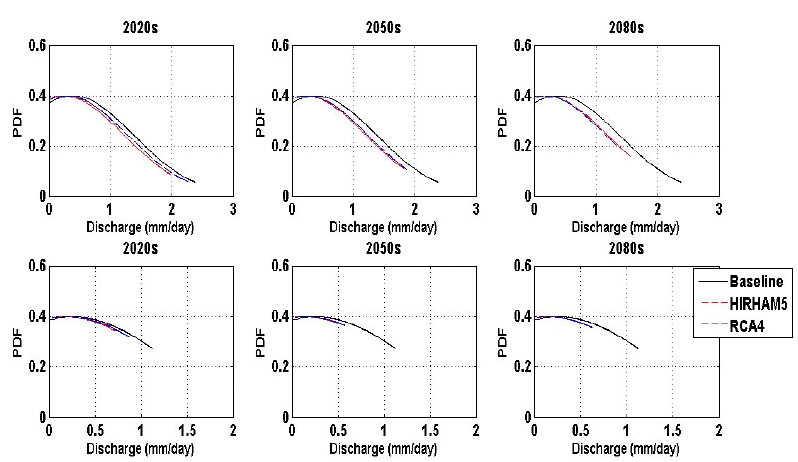
Figure 11. Probability distribution functions of annual mean discharge for the 2020s, 2050s and 2080s time horizons and the 1961–1990 baseline for the Bétérou catchment ( top ) and Bonou catchment ( bottom ) derived from RCP4.5 scenarios.